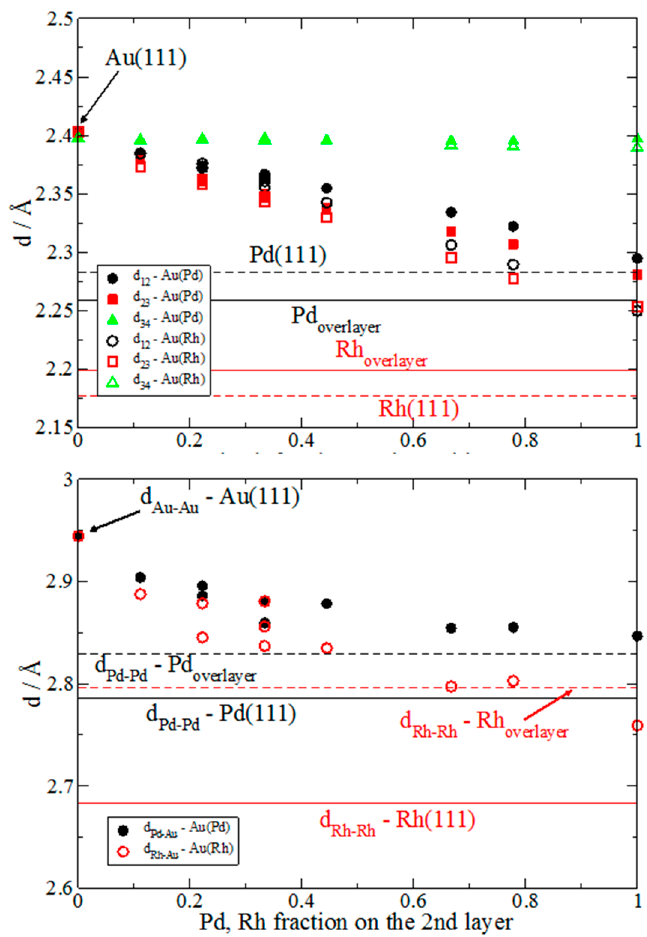
Figure 2. Interlayer separation ( upper ) and Pd-Au or Rh-Au distances ( lower ) as a function of the Pd or Rh fraction in the second layer. All the systems correspond to the ones presented in Figure 1. The (111) surfaces of gold, palladium, and rhodium were used as references. Systems with a complete monolayer of palladium or rhodium on top of gold surfaces were included for sake of comparison.